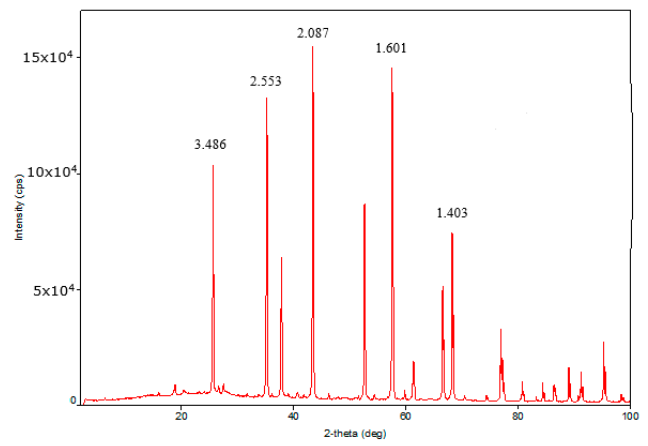
Figure 3. XRD pattern of highly porous catalyst.